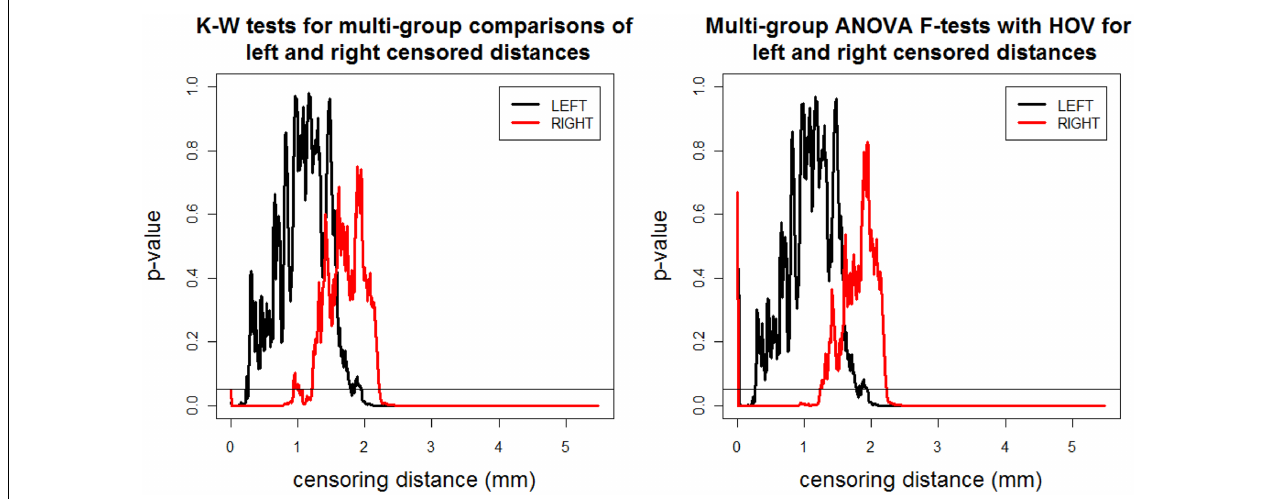
FIGURE 3 |The p -values versus censoring distance values (millimeter) for multi-group K–W test (left) andANOVA F -test with HOV (right) for LCDM distances for left (thick black solid line) and right (thin red solid line)VMPFCs . Horizontal lines are located at 0.05 to indicate the threshold values for